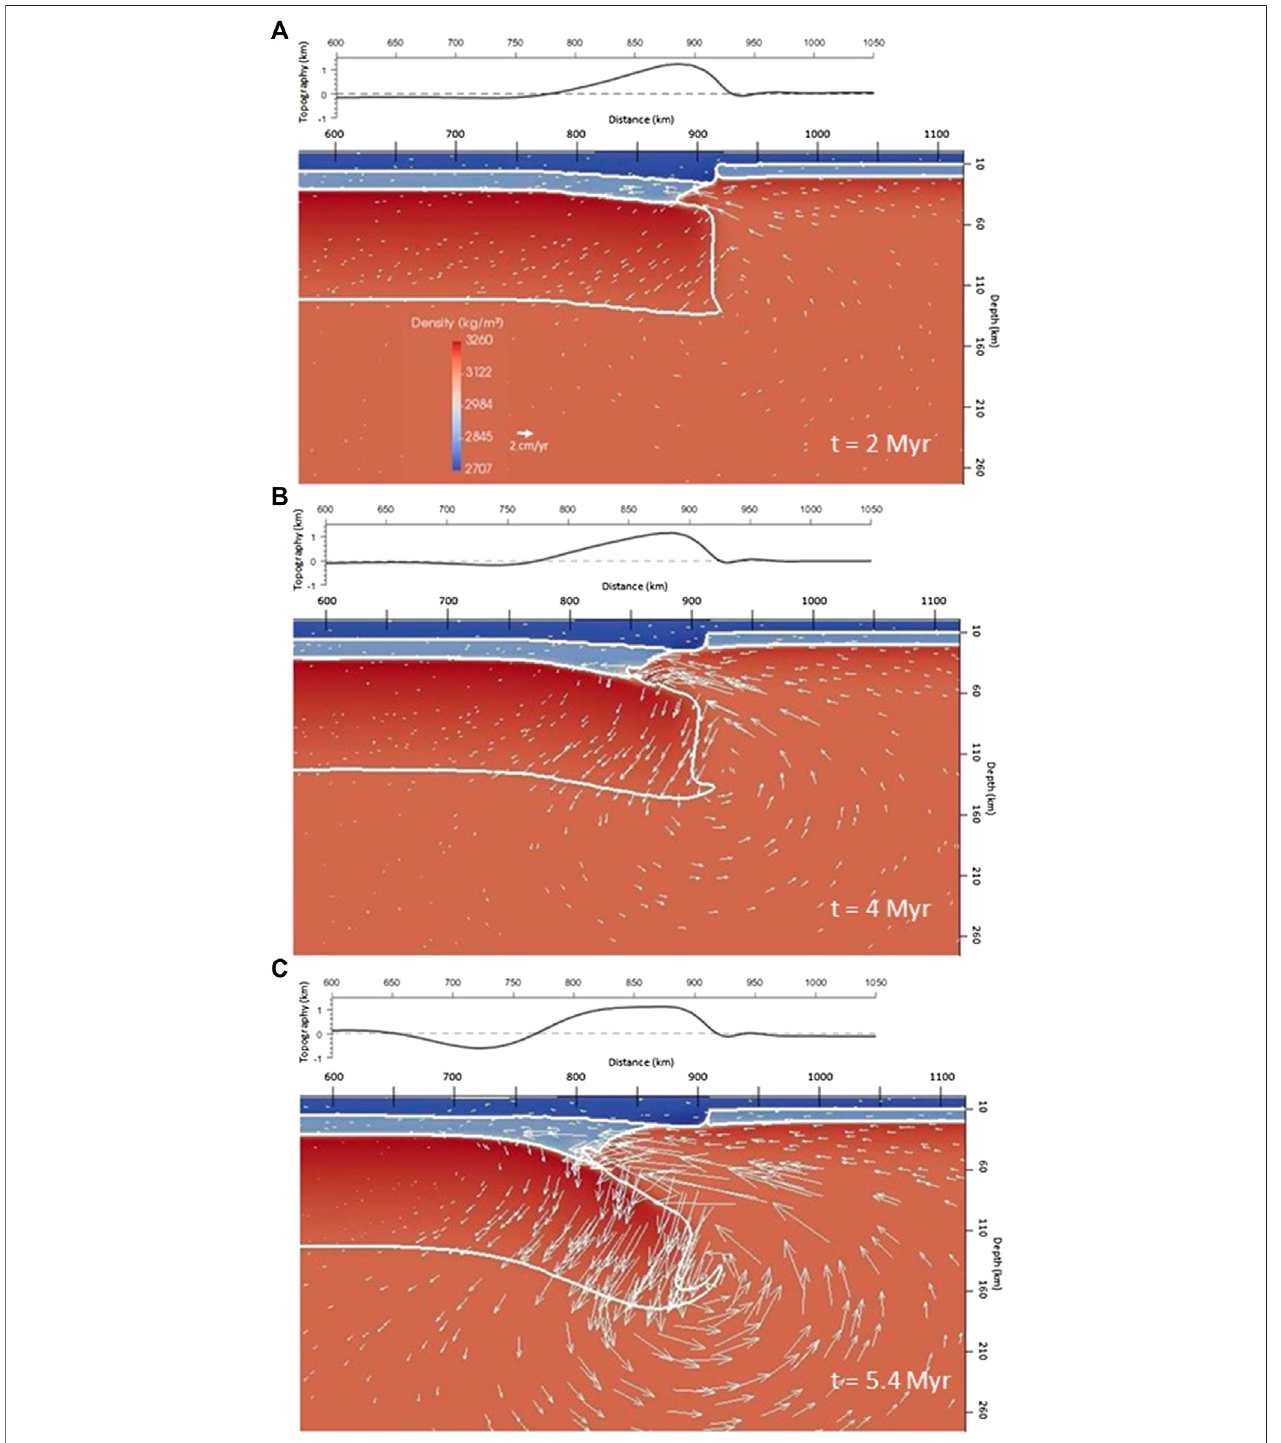
FIGURE 5 | Distribution of density and velocity fi eld and topographic response at different times (A) 2, (B) 4, and (C) 5.4 Myr of the Reference Model.